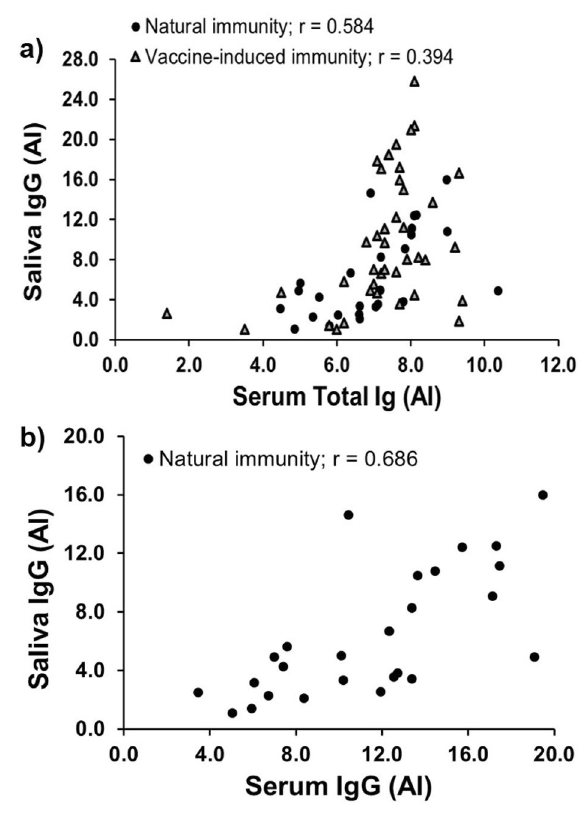
Figure 2. Concordance of SARS-CoV-2 spike protein RBD AI values among serum and saliva samples from individuals with natural and vaccine-induced COVID-19 immunity using the home-brew ELISA. SARS-CoV-2 RBD total antibody levels were measured in serum and SARS-CoV-2 RBD IgG antibody levels were measured in concentrated saliva samples using a laboratory-developed ELISA. ( a ) Total RBD antibody levels in serum and RBD IgG antibody levels in saliva samples from convalescent plasma donors (n = 26) with natural COVID-19 immunity and individuals with vaccine-induced COVID-19 immunity (n = 40). ( b ) RBD IgG antibody levels in saliva and serum from convalescent plasma donors (n = 26) with natural COVID-19 immunity. AI antibody index.